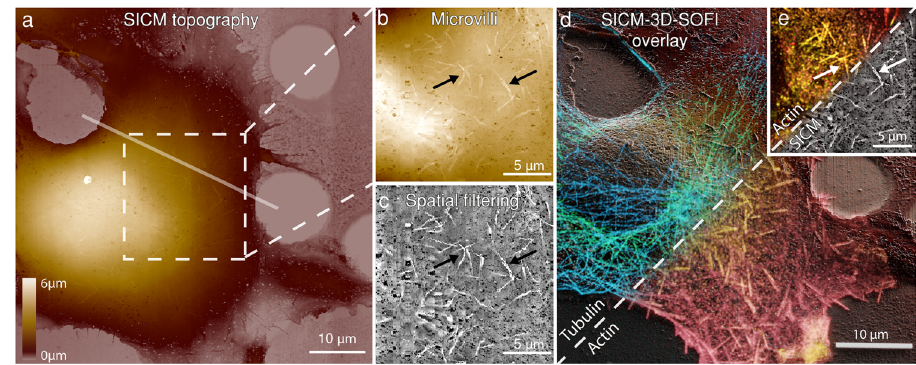
Fig. 4 Correlative SICM and 3D SOFI imaging of cytoskeletal components in a fi xed COS-7 cell. a Topographical SICM map of a fi xed COS-7 cell imaged on a dedicated SICM setup after two-color 3D-SOFI acquisition. Corresponding fl uorescence images are shown in Fig. 3. The scan resolution is 1024× 1024 pixels over an 80 μ m × 80 μ m area with a corresponding pixel size of 78 nm. The pixel acquisition rate was 200 Hz with a hopping height of 6 μ m. Semi- transparent line shows the cross-section area displayed in Fig. 5 ( a , b ). b Leveled zoom-in of the upper part of the cell by mean plane subtraction, showing the topography of microvilli (marked with black arrows) on the surface of the cell. c Spatial band-passed fi ltered SICM image to highlight multiple microvilli structures. d 3D rendered correlative SICM and two-color 3D-SOFI overlay. The tubulin and actin channels are rendered as volumes consisting of 22 planes, while topographical SICM information is used for a height representation in the Blender 3D software (Supplementary Movie 1). e Correlative SOFI and SICM overlay (white arrows correspond to the black arrows in b and c ). This fi gure is representative of more than 10 correlative SICM and 2-color 3D- SOFI single-cell images obtained from at least two independent